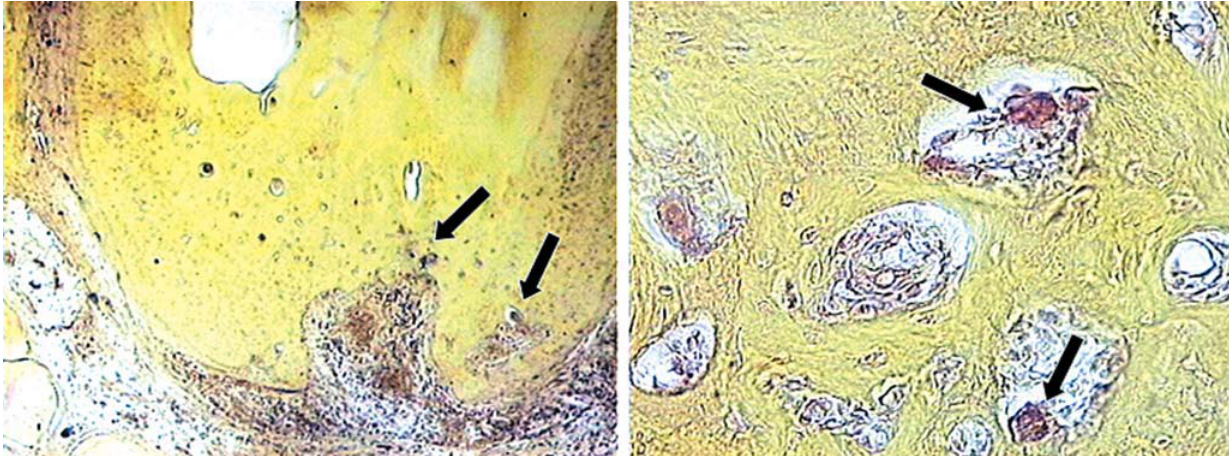
FIGURE 6 - A - SEM micrograph of apical and periapical regions of the same specimen of Figs. 4 and 5. This specimen scored 4 in ML. Note presence of microorganisms within apical lacunae (arrows) near root resorption area. B&B. 40X. B – Close-up view. Microorganisms (arrows) within lacunae and ramifications of apical cementum. B&B.